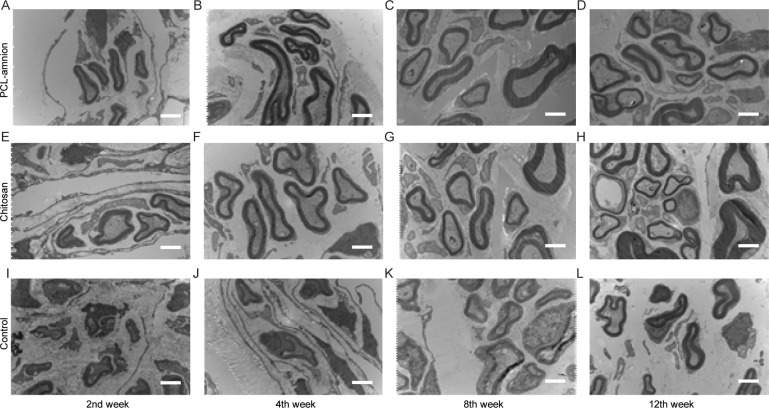
Transmission electron microscope images of the nerve tissues at each time point (x10000).(A-D) The PCL-amnion group. (E-H) The chitosan group. (I-L) The control group. Scale bar = 2 μm.